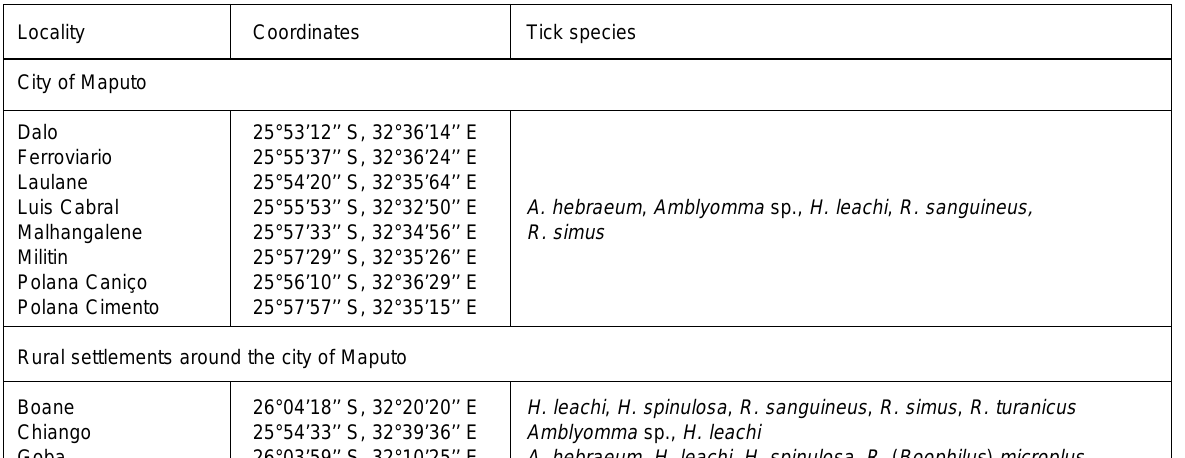
TABLE 1 Localities in Mozambique at which ticks were collected from dogs Locality